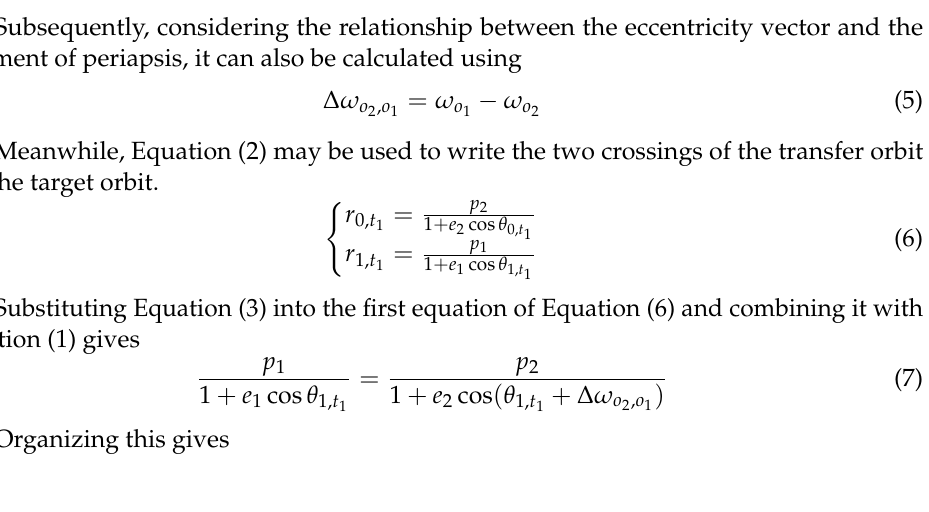
Figure 2. Geometric interpretation of flyby positions.